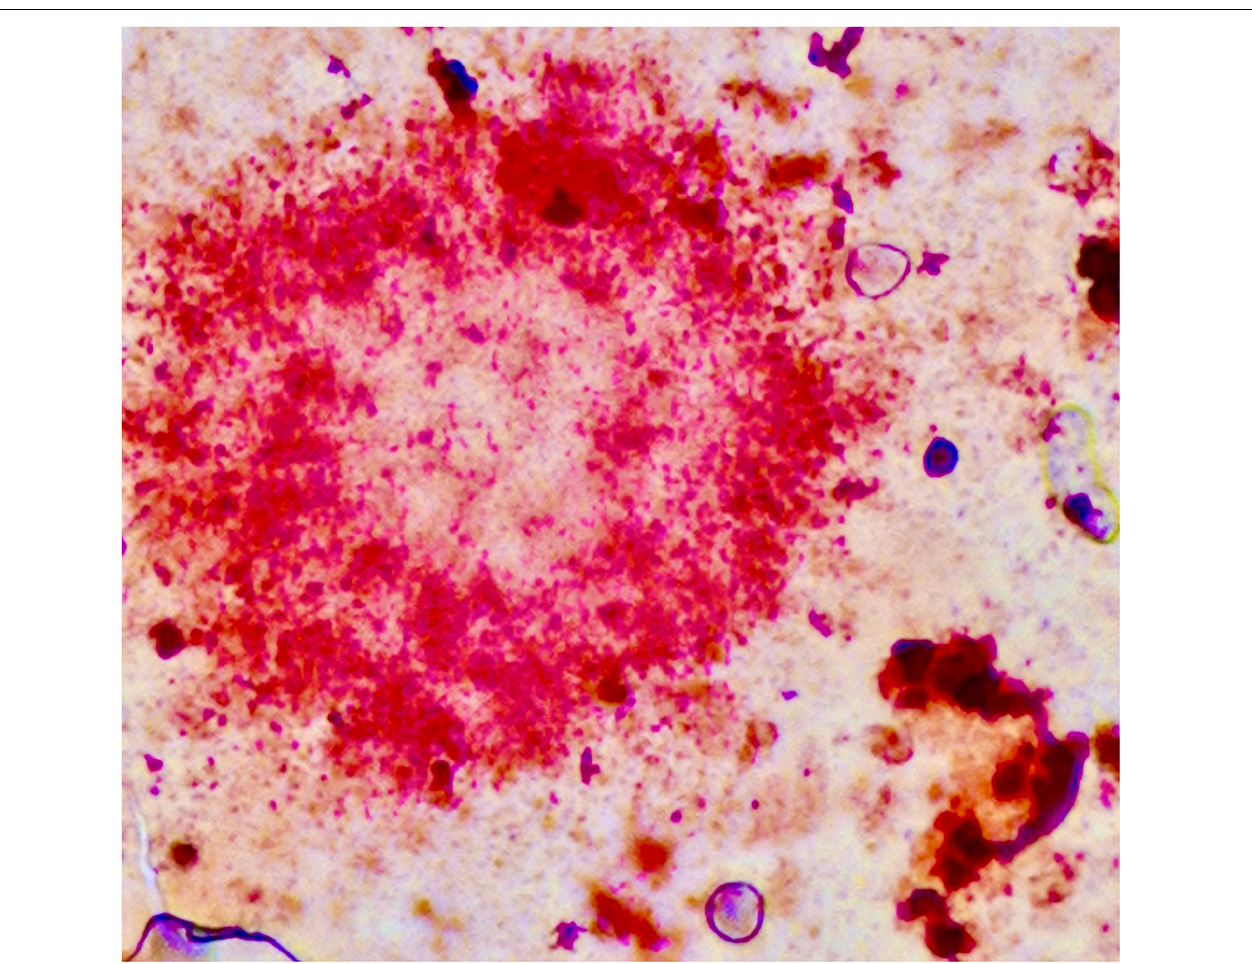
FIGURE 4 | Amyloid plaque stained using the Herxheimer technique (Sudan IV). Significant amounts of lipids are found inside the plaque and in neighbouring glial cells. One cell probably representing a microglial cell is shown in the lower right. Formalin-fixed brain tissue, frozen section. Photograph taken by the authors (MBG): 20 × oil primary magnification. Tissue section from Alois Alzheimer’s laboratory (Alzheimer, 1911; Graeber et al.,